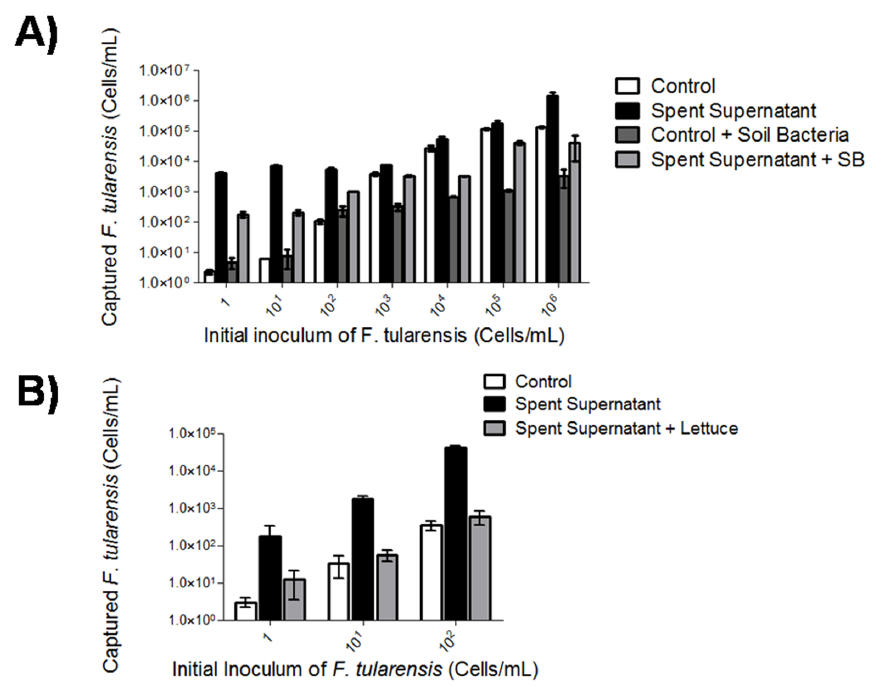
Fig. 2. Spent filtrate supplementation results in increased detection of F. tularensis in mixed cultures. A) F. tularensis was spiked in a ten-fold serial dilution in 10 9 CFU/mL of soil bacteria or inoculated as a pure culture and incubated in control broth (TSB with 0.1% L-cysteine) or spent filtrate (composition: TSB and 0.1% L-cysteine and 10% spent culture filtrate) overnight at 37 ˚ C with 120 rpm shaking speed. B) F. tularensis (1– 10 2 cells/mL) was spiked in 10 9 CFU/mL of lettuce bacteria. Supplementation of TSB and 0.1% L-cysteine with spent culture filtrate resulted in F. tularensis detection at all inoculums (1–10 2 cells/mL). Control medium combined with lettuce showed Cp values greater than 34 and were considered negative for F. tularensis . All samples were conducted in triplicate with technical triplicates. Legend: Control 5 white bar, Spent filtrate 5 black bar, Control and soil bacteria 5 dark grey bar, and Spent filtrate and soil/lettuce bacteria 5 light grey bar.